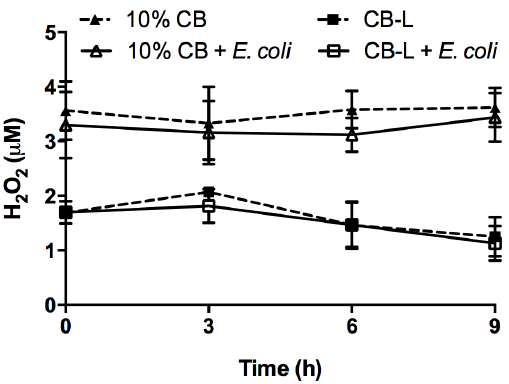
Fig. 3. Hydrogen peroxide concentration in 10% CB suspensions and CB-L. Hydrogen peroxide levels were measured in 10% CB suspensions and CB-L with or without the addition of stationary-phase E. coli ATCC 25922. Values represent the average H 2 O 2 concentration ¡ SD for three independent